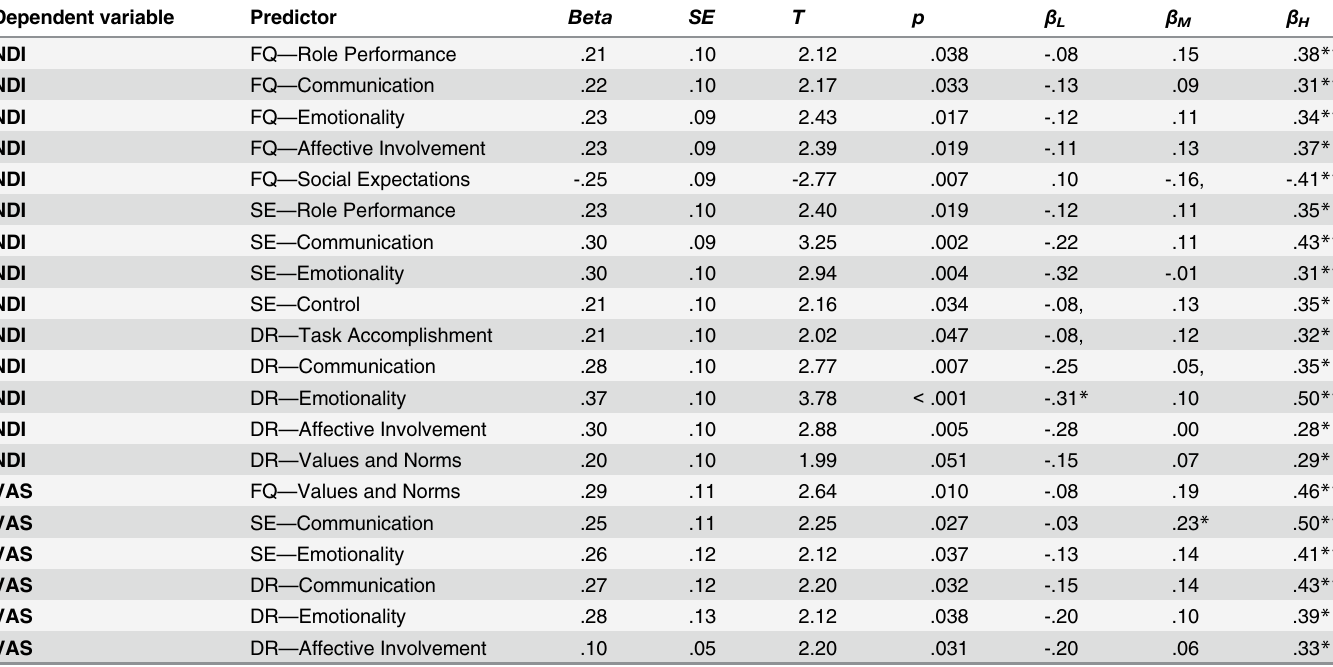
VAS: Visual-Analogue Scale measuring neck pain; NDI: Neck Disability Index; FQ: Family Questionnaire; SE: Self-Estimating Questionnaire; DR: Diadic Relationship Scale. β L , β M , β H : beta coef fi cients for the relationship between a given predictor and the dependent variable, respectively, at low (1 SD below the mean), medium (mean), and high (1 SD above the mean) values of age. Only signi fi cant results are included in the